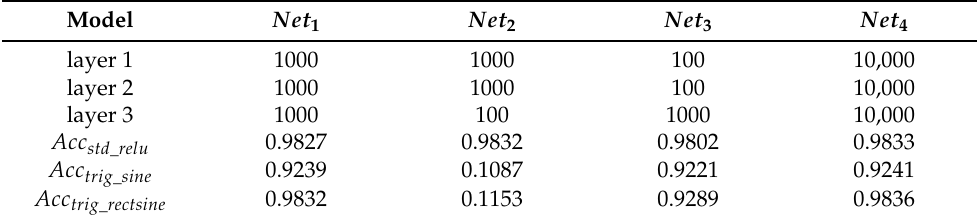
Table 3. MNIST test accuracy.